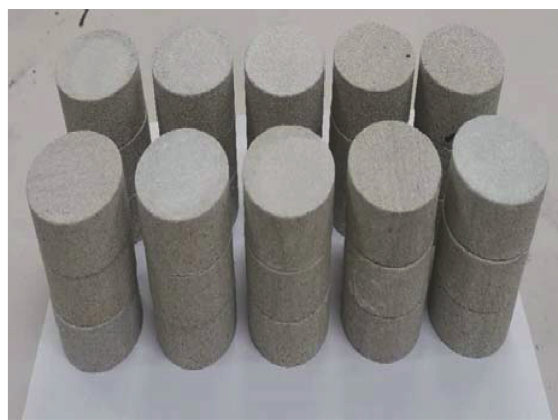
Figure 1: Partial sandstone samples.